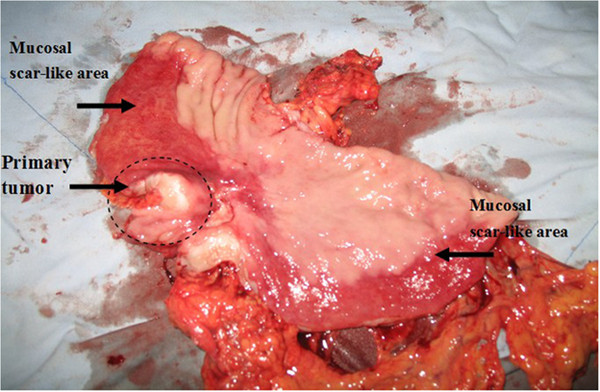
Post-operative specimen. The mucous membrane shows scar-like changes after chemotherapy in areassupplied by the right gastroepiploic artery, but the gastric mucosa outside the chemotherapy delivery area was normal.